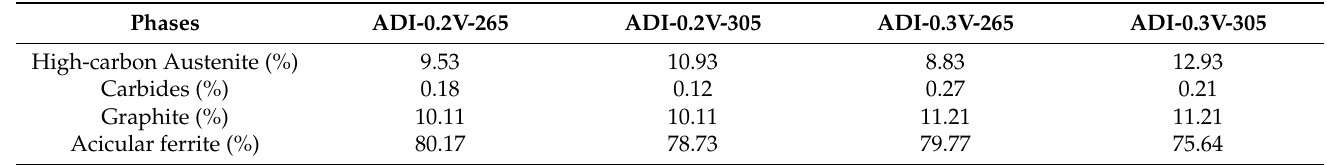
Table 4. The volume fraction of phases for the ADIs